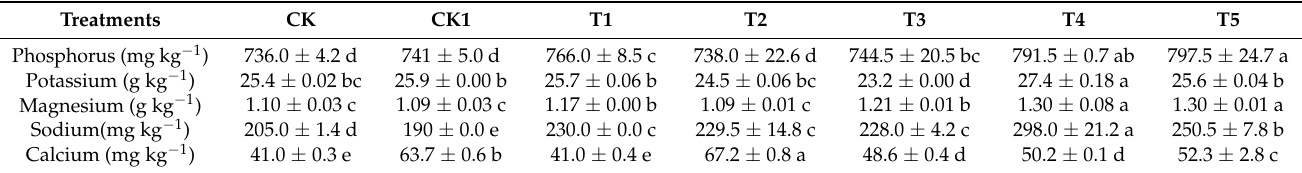
Table 4. The macronutrient elements in fruiting bodies cultivated on different substrates # *.